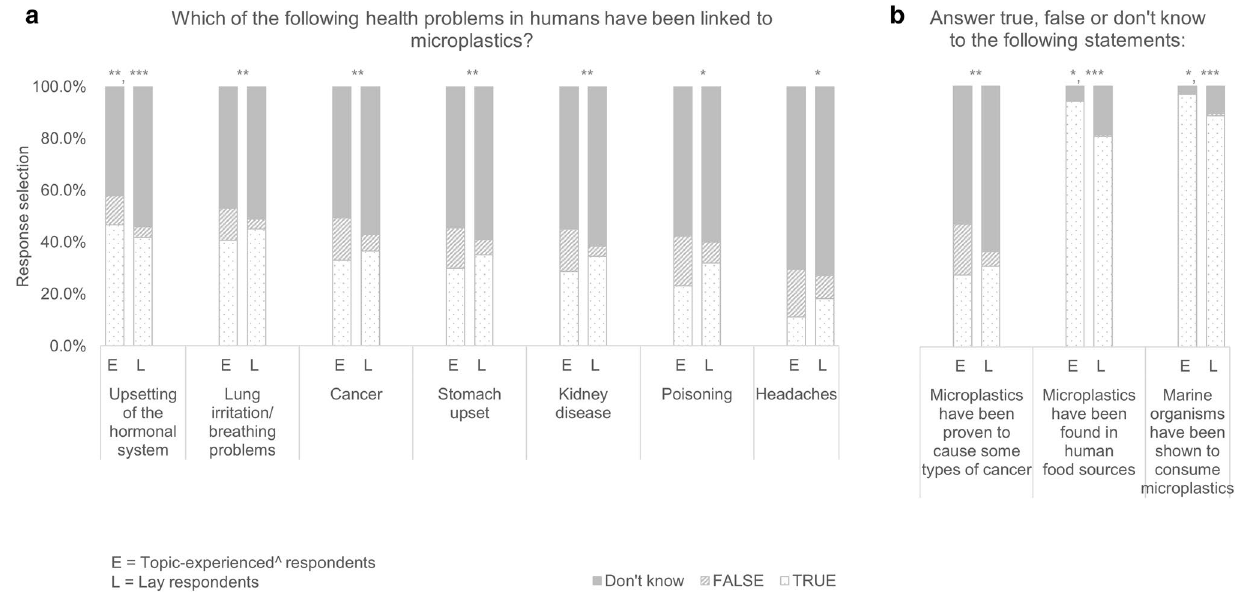
Figure 2. Response selection of lay respondents (n = 1430) and experienced^ respondents (n = 251) to ( a ) ‘Which of the following health problems in humans have been linked to microplastics?’ and ( b ) ‘Answer true, false or don’t know to the following statements:’. Statistical test results see Table 2; statistical difference between categorical answers: *true, **false, ***don’t know. Survey results obtained in 2018/2019. ^acknowledged their previous or current work on the topic of plastics and/or microplastics as an environmental contaminant or involvement in a research project on this topic.